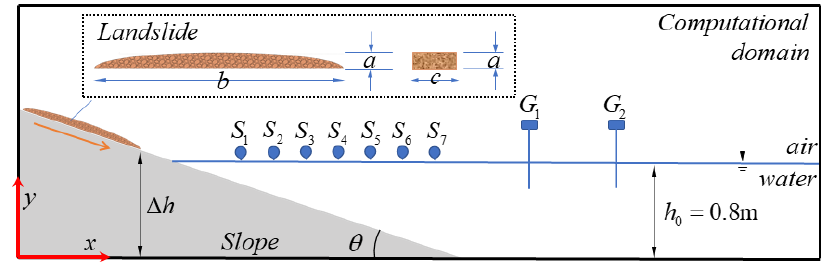
Figure 2. The schematic diagram of the numerical experimental layout based on Romano et al. (2016).